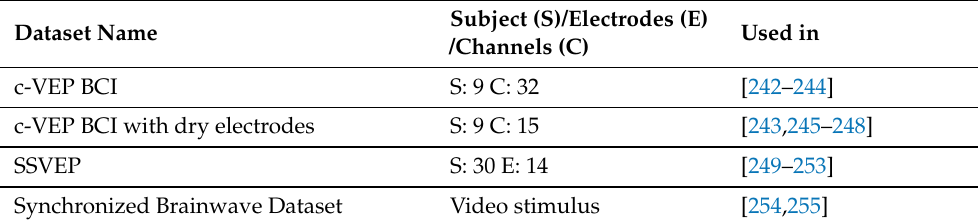
Table 8. A table of different types of Visually Evoked Potential (VEP) datasets in BCI. These datasets are collected from